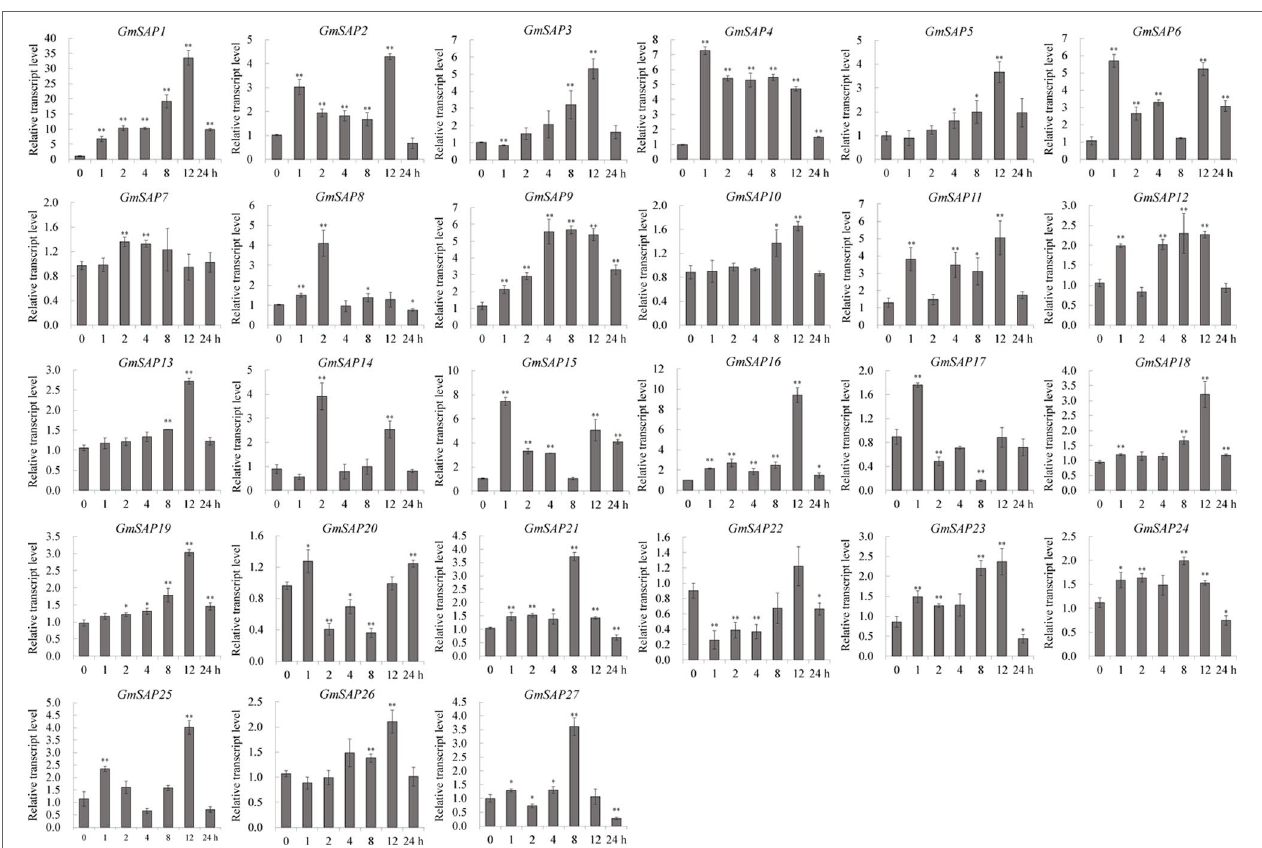
FiGURe 7 | Patterns of soybean stress associated proteins (SAPs) transcript accumulation under abscisic acid (ABA) treatment. The data were normalized to the soybean internal control gene GmCYP2 . Three biological replicates were performed, and the values are presented as the means ± SD. Asterisks indicate statistical significance (*, P 0.05; and **, P 0.01; Student’s t test) compared with the corresponding controls.